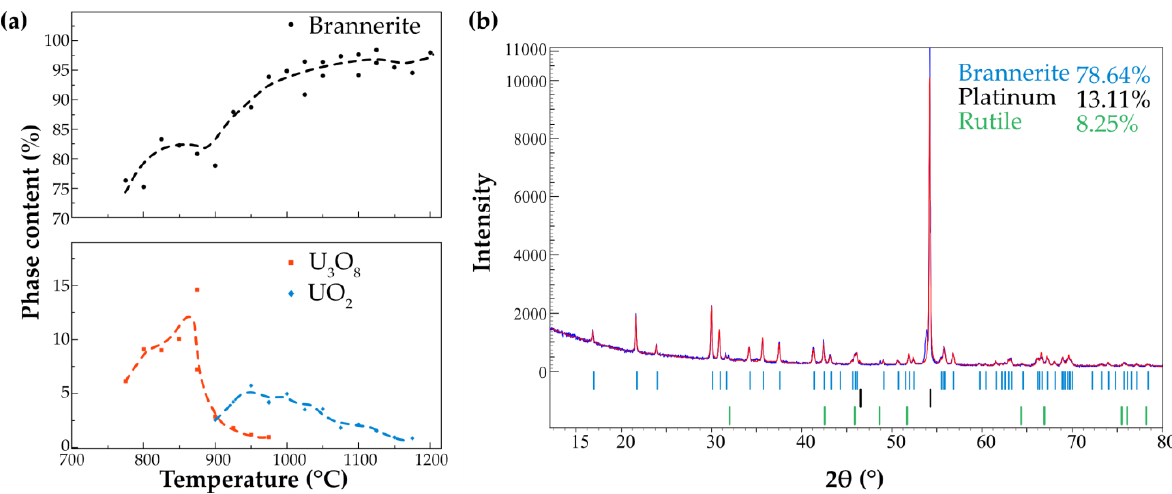
Figure 5. The content of the uranium oxide phases formed during the heating of metamict brannerite ( a ). XRD pattern obtained after cooling ( b ).